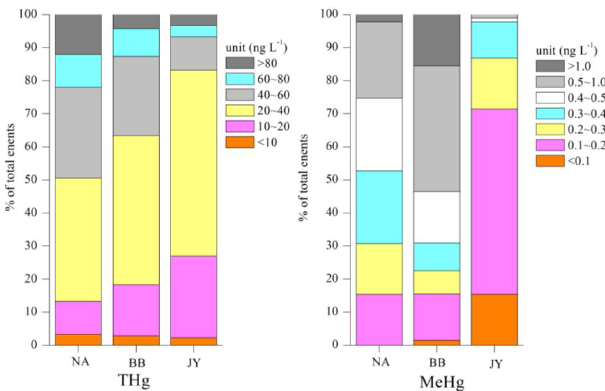
Fig. 3. The frequency distribution for THg and MeHg concentra- tions at three sites during one year period.